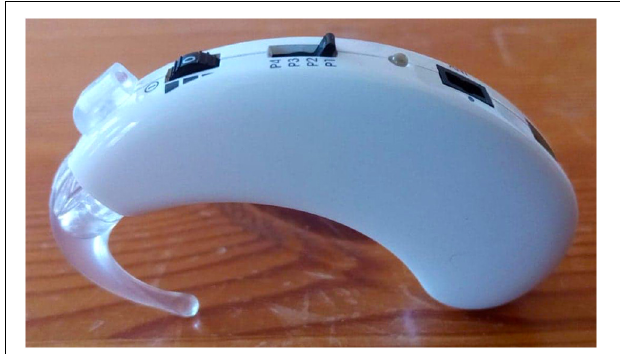
FIGURE 1 | Modified behind-the-ear